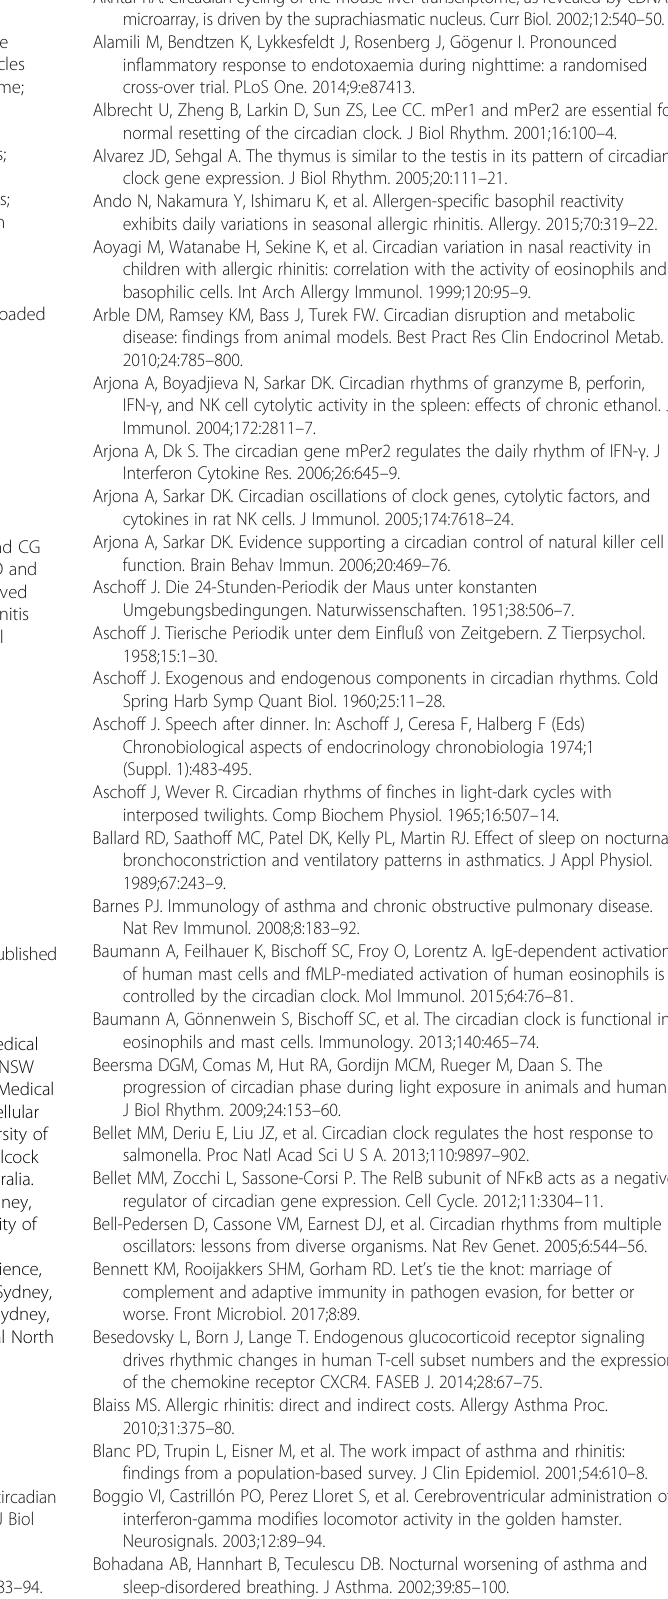
Abbreviations Adora2a : Adenosine A2a receptor; Adrb2 : Adrenergic β 2 receptor; ANS: Autonomic nervous system; AR: Allergic rhinitis; BMAL1: